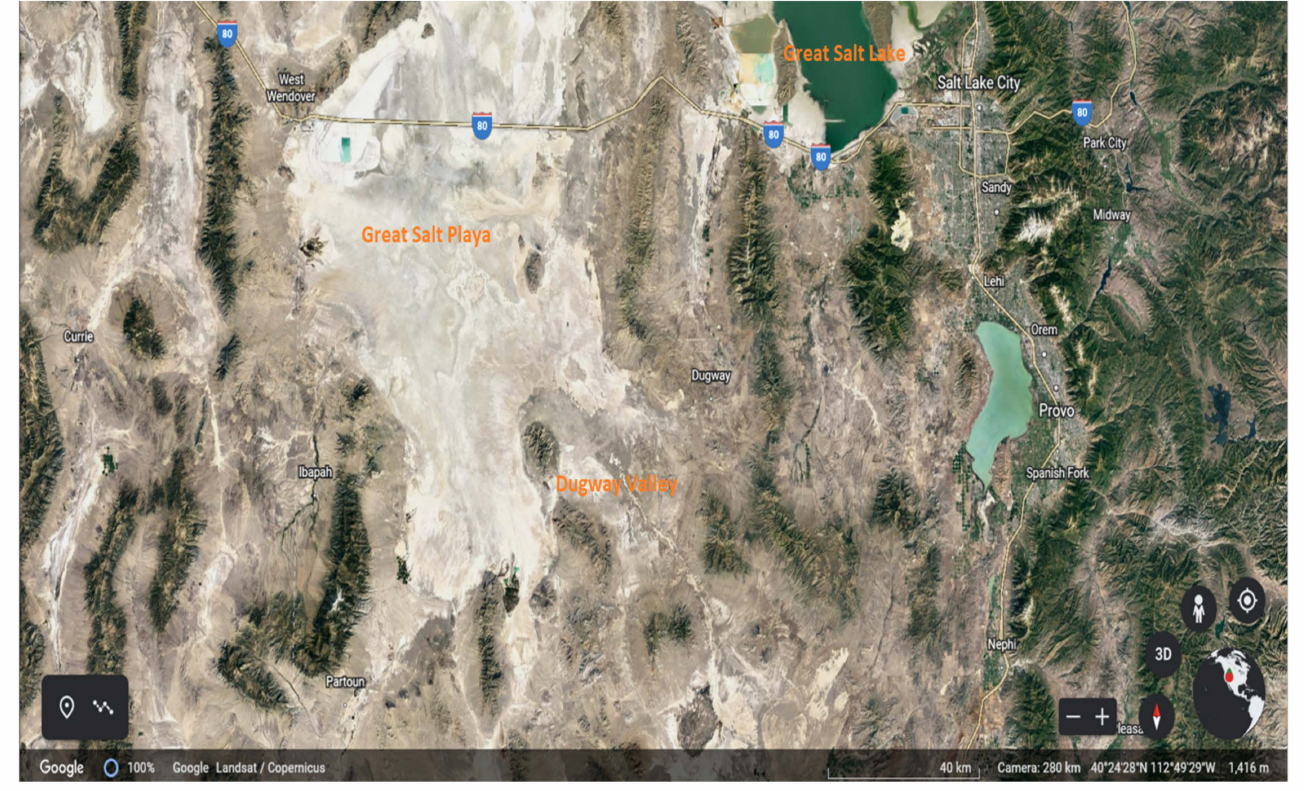
Figure 3. Notable features referred to in the